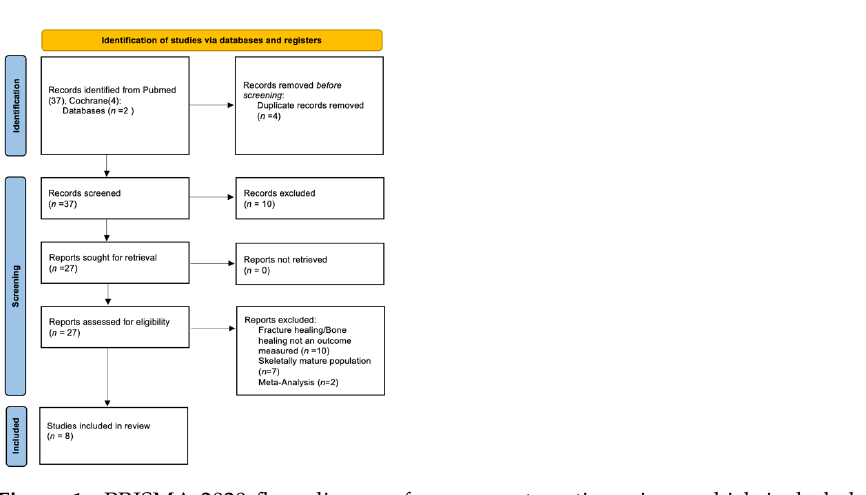
Figure 1. PRISMA 2020 flow diagram for new systematic reviews which included searches of databases and registers only.